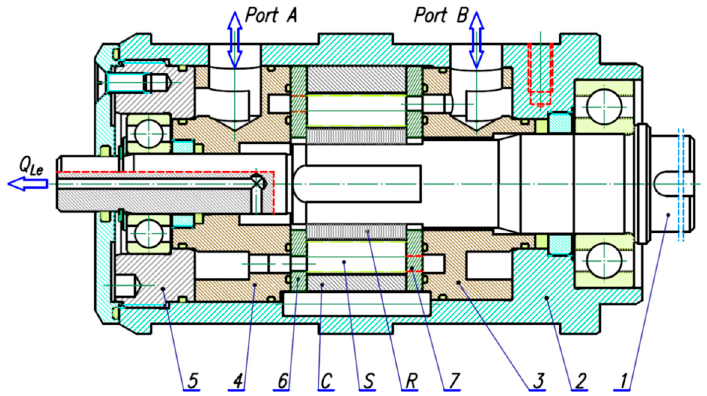
Figure 6. Hydraulic satellite motor [12,24]: C —curvature (stator); S —satellite; R —rotor; 1—shaft; 2—case; 3 and 4—inflow and outflow manifolds; 5—rear body; 6 and 7—distribution (compensation) plates.